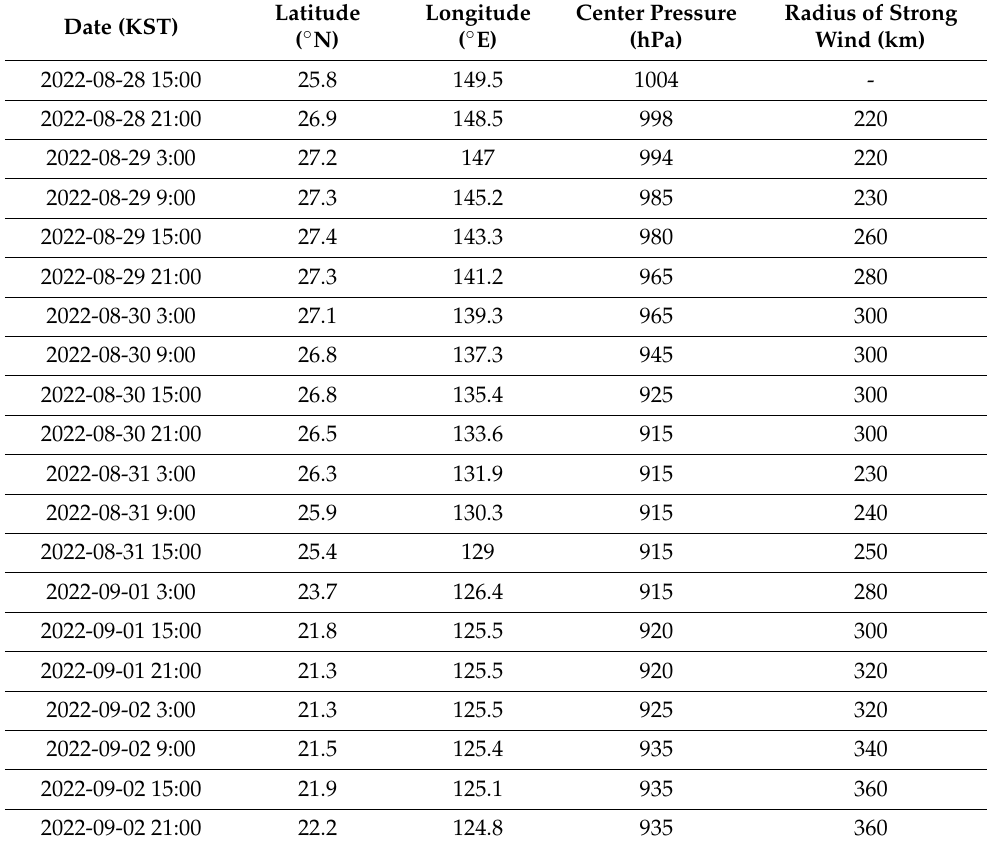
Table 2. Input parameters of Hinnamnor (2211) for the parametric typhoon